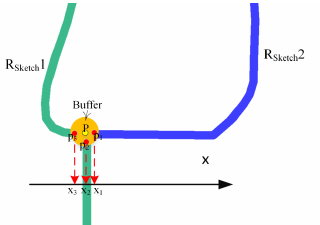
Figure 10. P is the intersection of two roads R Sketch 1 and R Sketch 2. Buffer is the buffer of a certain radius at P . Points p 1 , p 2 , and p 3 indicate the intersections between Buffer and the two roads. x 1 , x 2 , x 2 are the x -coordinate values of points p 1 , p 2 , and p 3 , respectively.